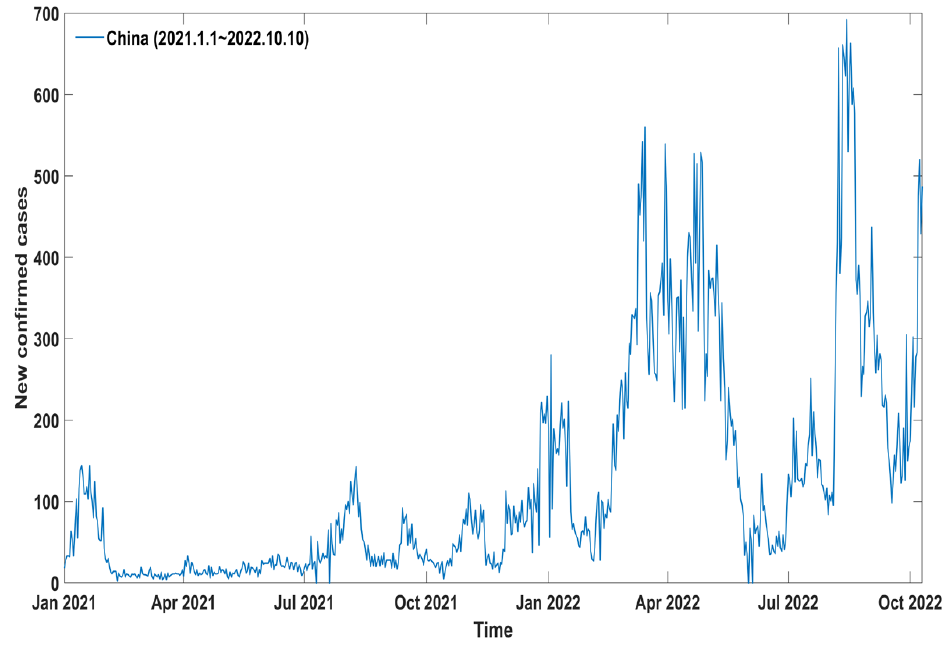
Figure 2. Original sequence diagram.